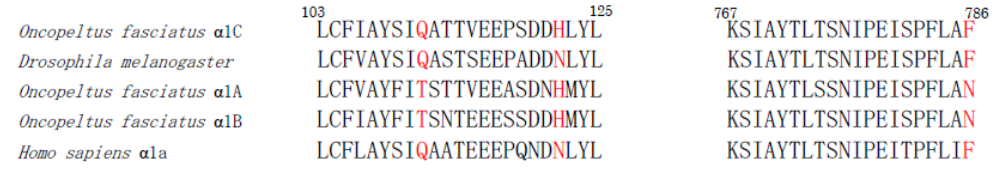
Figure 5. Comparison of amino acid residues of three isoforms of Oncopeltus fasciatus Na + /K + -ATPases, and those of Drosophila melanogaster and Homo sapiens . The critical residues are marked with red. GenBank accession numbers are AFU25689, AFU25688, AFU25687, AAC05260, and NP_000692, respectively. The critical amino acid residues for the binding of ouabain were marked with red. Nicotine, an alkaloid derived from the leaves of tobacco plants ( Nicotiana tabacum , Nicotiana attenuate, and other Nicotiana species), is the primary addictive agent in tobacco products and binds to nicotinic acetylcholine receptors [289]. Nicotine is stored in the trichomes of tobacco leaves ( Manduca sexta ) and generalist ( Spodoptera exigua ) lepidopteran herbivores. M. sexta is highly tolerant to nicotine. Interestingly, ingestion of nicotine and its N-oxides to M. sexta larvae induces cytochrome P-450 CYP6B46. Nicotine-induced CYP6B46 is used to efflux midgut-nicotine into the hemolymph